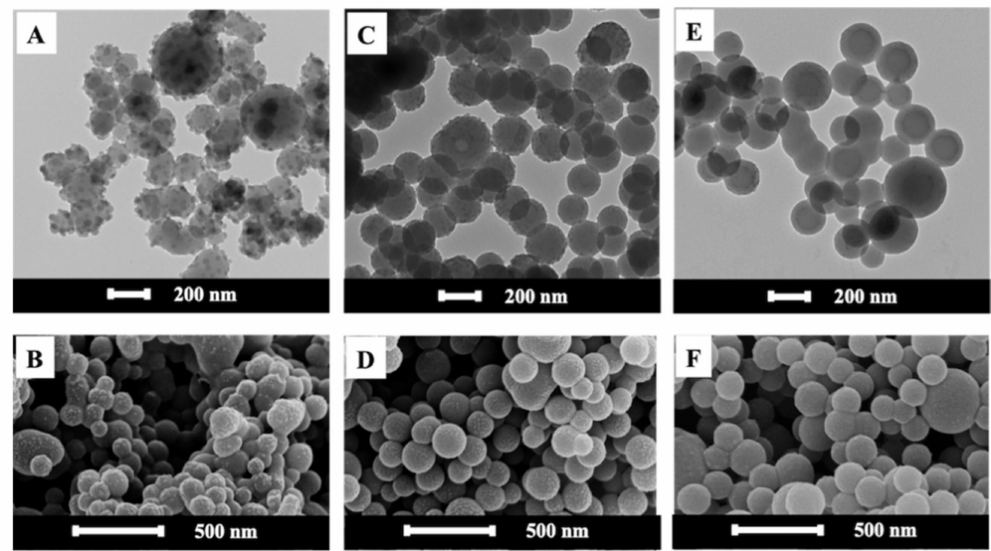
Figure 3. TEM and SEM images of spherical ZPPs synthesized by using 0.5 ( A , B ), 1.0 ( C , D ), and 2.0% ( E , F ) of KPS